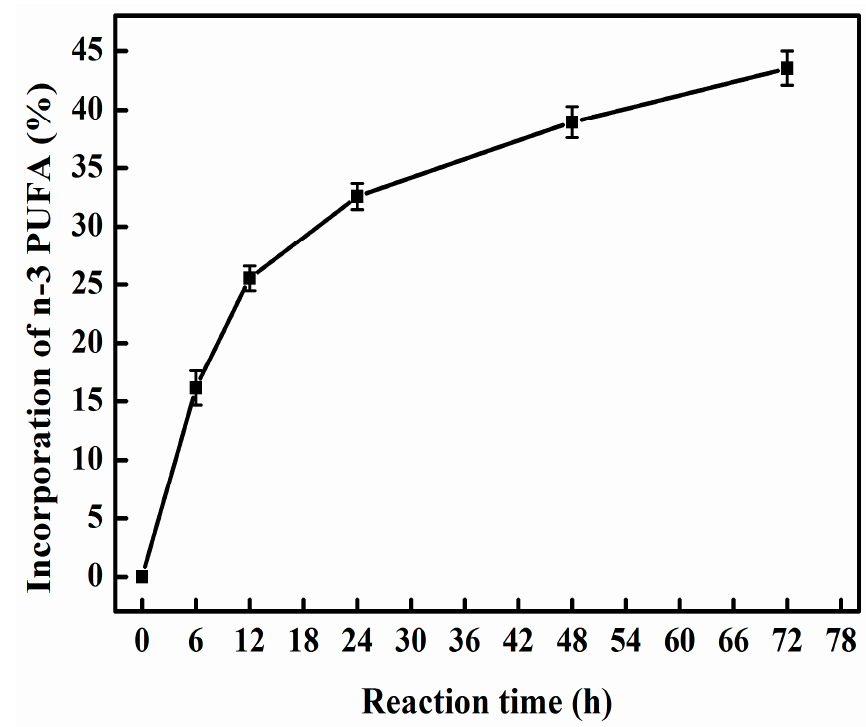
Figure 5. The time course of immobilized MAS1 lipase-catalyzed transesterification of PC with n-3 PUFA-rich EE. Reaction conditions were as follows: n-3 PUFA-rich EE / PC mass ratio of 6:1, enzyme loading of 20% ( w / w ), reaction temperature of 55 °C, and water dosage of 1.0% under N 2 .